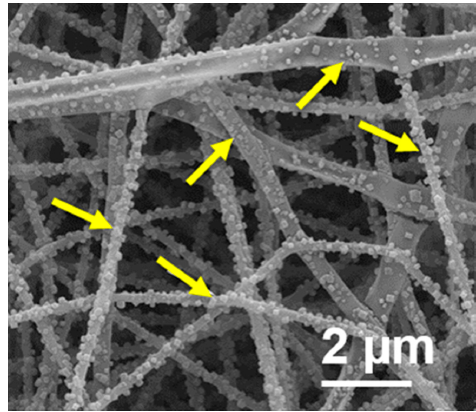
Figure 2. SEM image of PUL fiber (15% PUL, 1.0 M NaCl) at high magnification. Crystals of sodium chloride are observed on the fiber surfaces. Arrows indicate salt crystals.